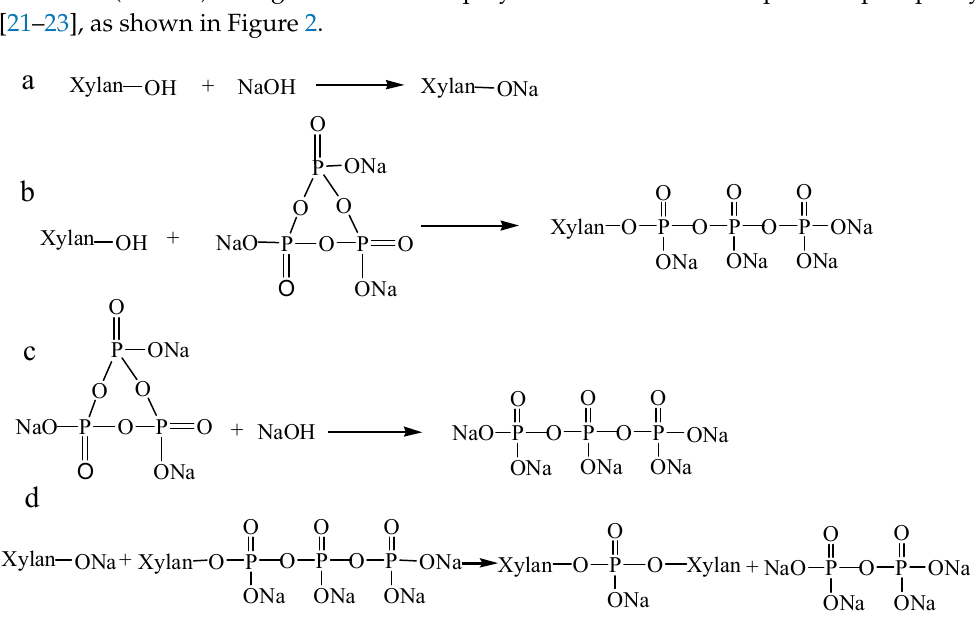
Figure 2. The reaction of xylan and sodium trimetaphosphate (STMP).